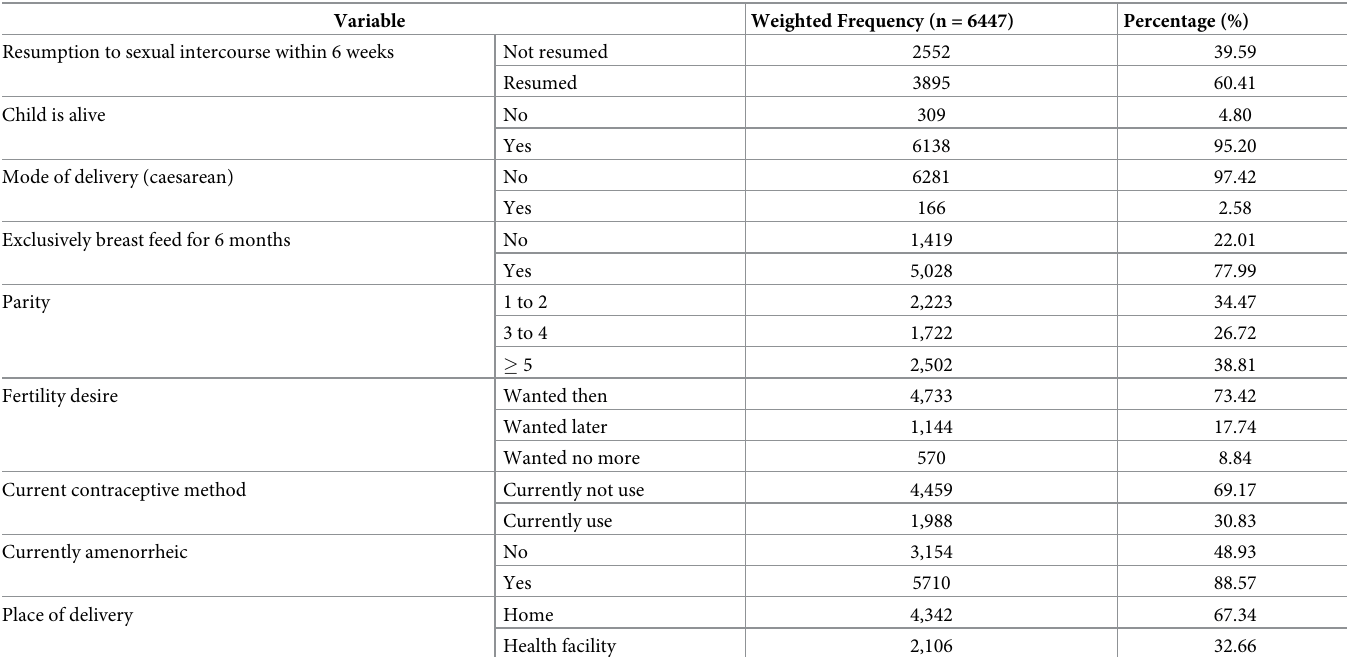
Table 3. Obstetrical related